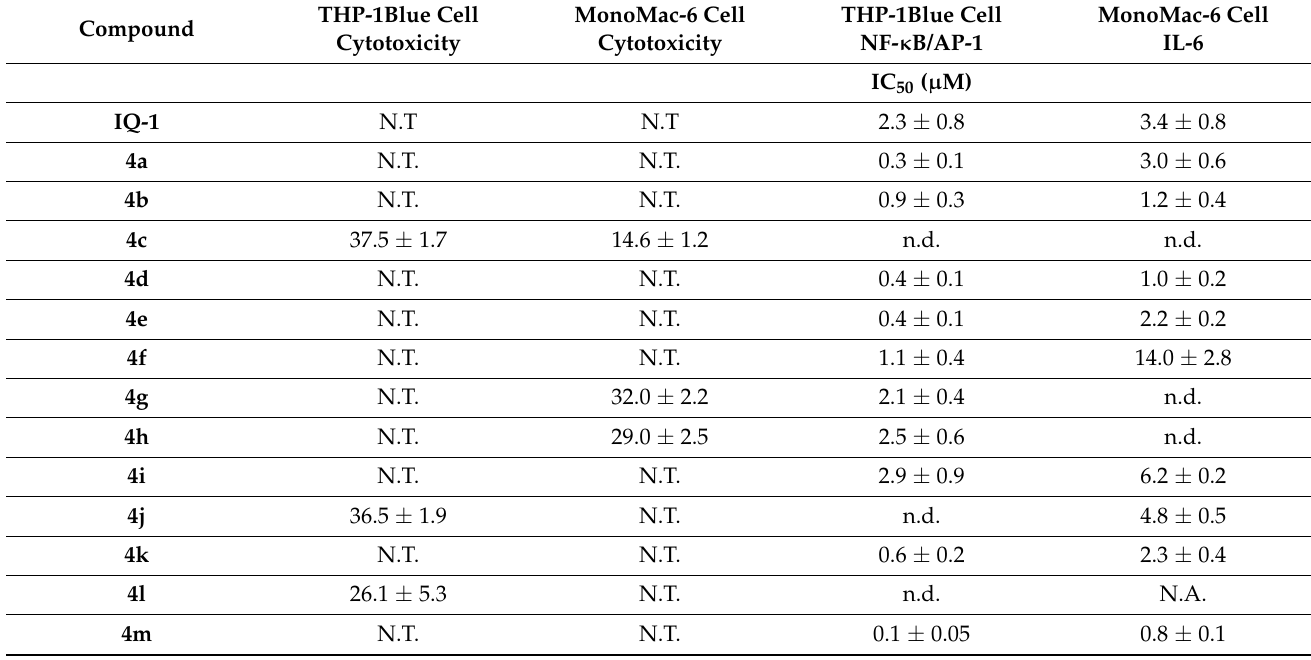
Table 4. Effect of the compounds on LPS-induced NF- κ B/AP-1 transcriptional activity in THP1-Blue cells, LPS-induced production of IL-6 in MonoMac-6 cells, and